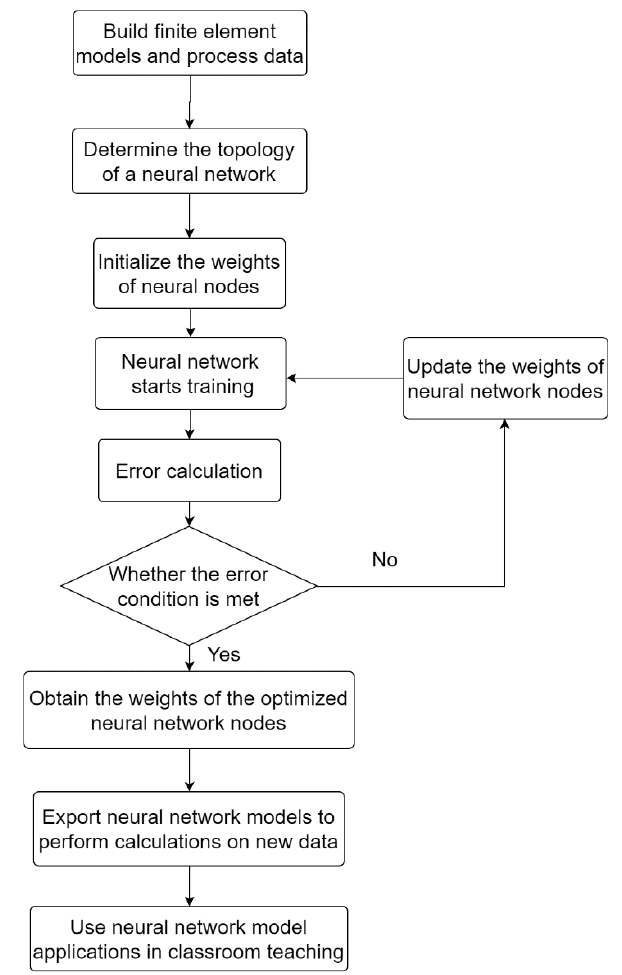
Figure 2. Operation process of neural network.